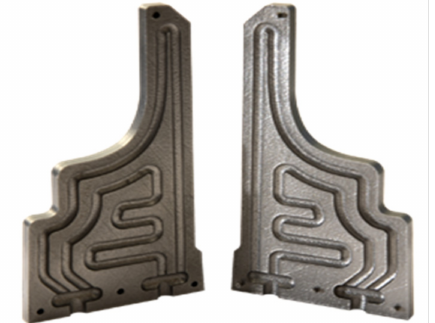
Figure 10. AM tool and die with conformal cooling channels